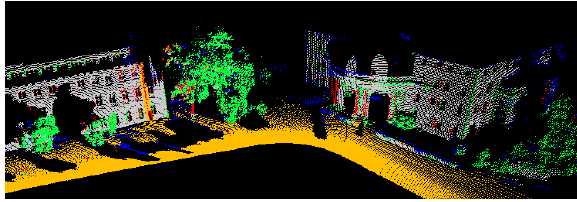
Figure 1: 3D point cloud with assigned labels (wire: blue, pole/trunk: red, fac¸ade: gray, ground: brown, vegetation: